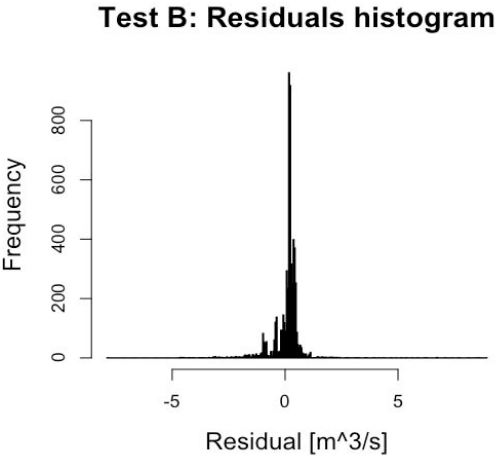
Fig. 6. Test B: histogram of the residuals of the simulated discharge with respect to the measured